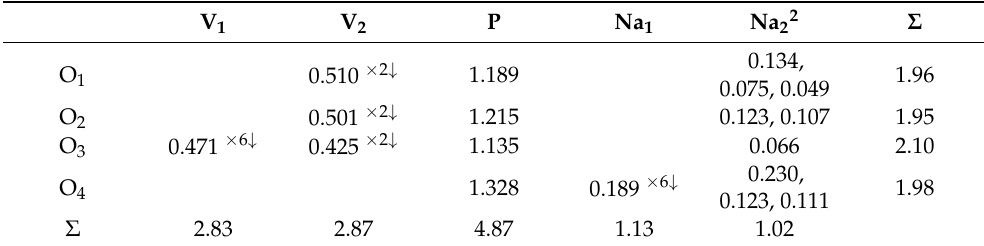
Table 3. Bond–valence data 1 .